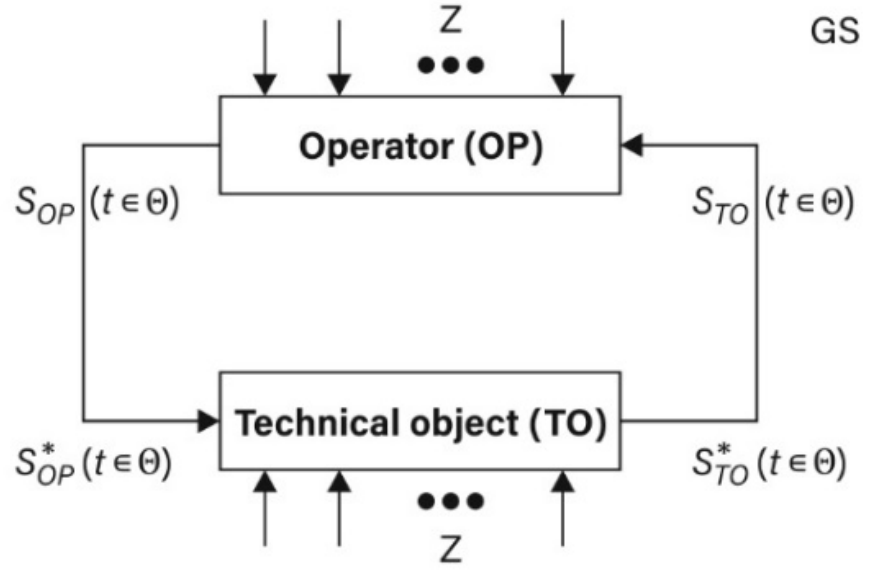
Figure 3. Process-based approach toward the (GS) for (OP) and (TO) during the time for a ( t ∈ Θ ) logistics game (LG), adapted from [33].